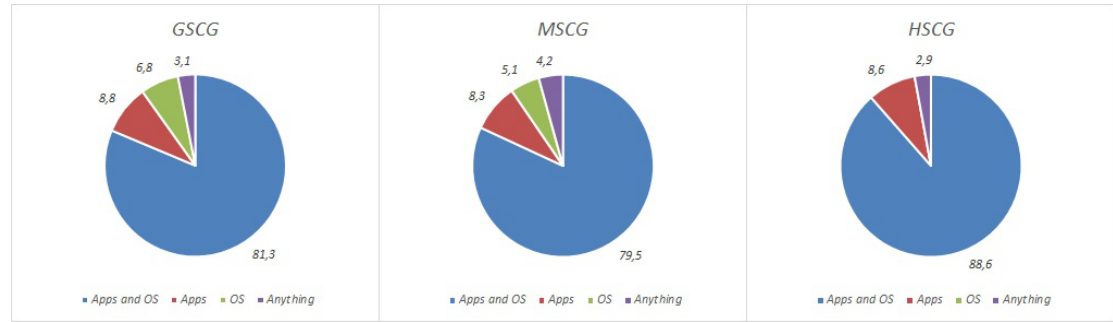
Figure 2. Do you regularly update the software on your mobile device? (cellphone/tablet).